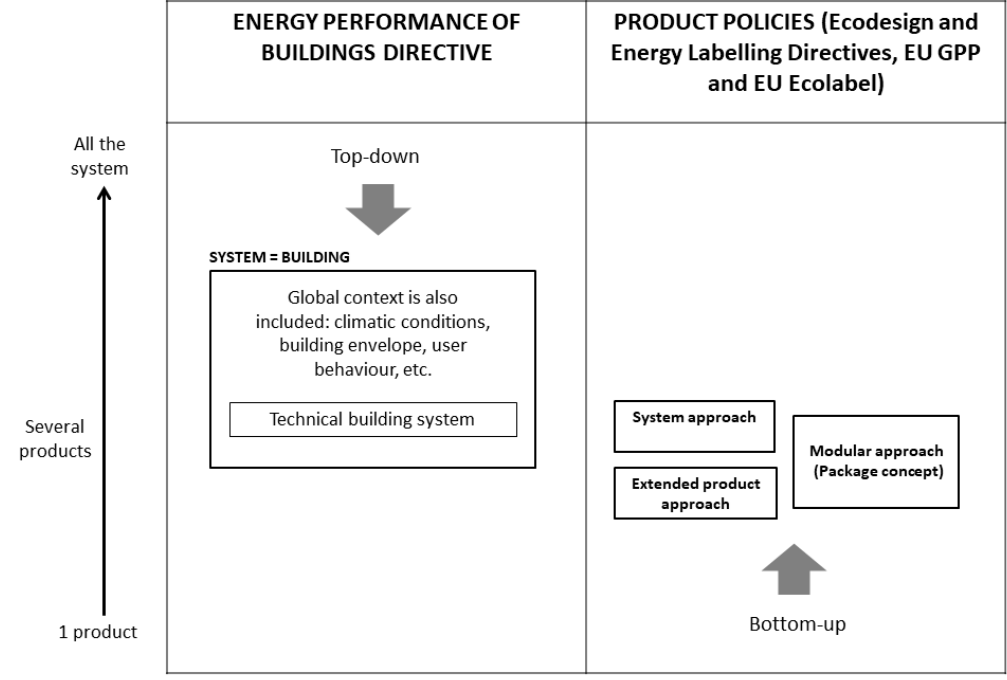
Figure 10. Link between the EPBD and building-related product policies.